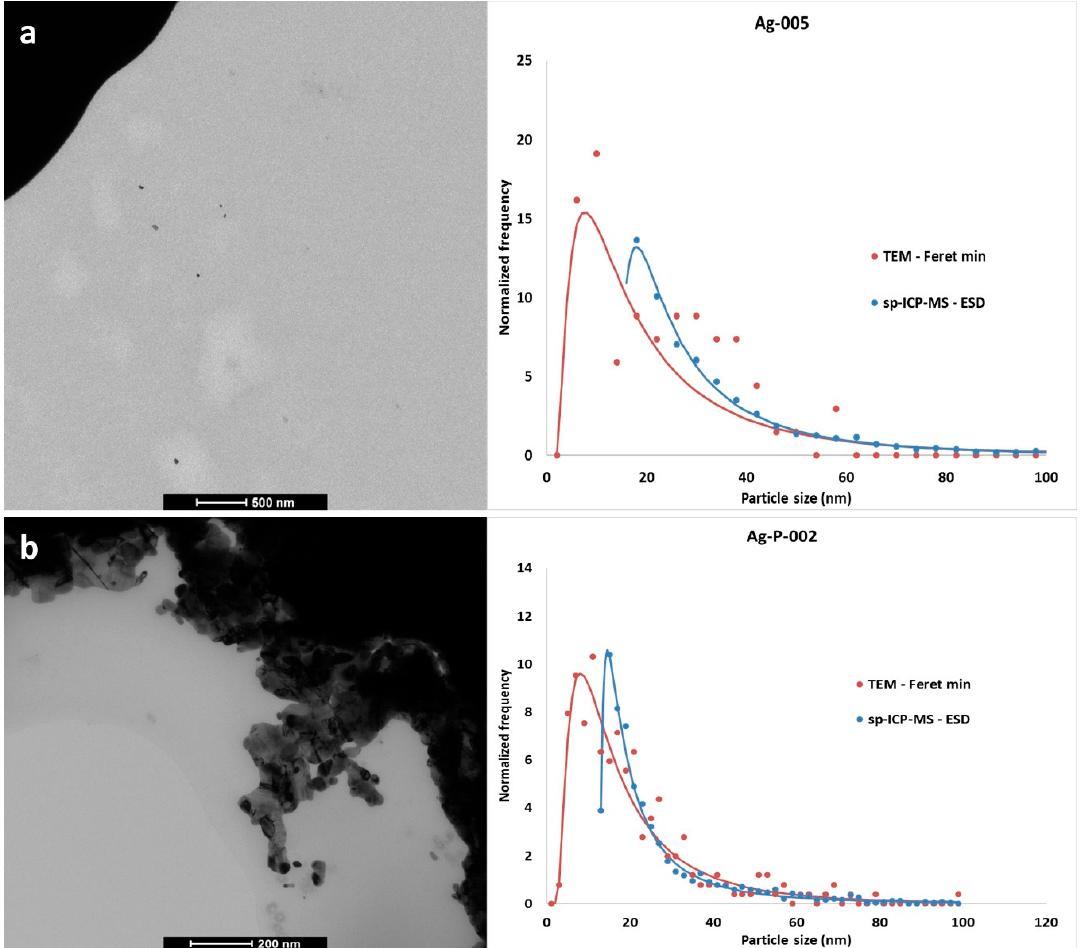
Figure A1. Representative TEM micrographs and silver particle size distributions determined by TEM and spICP ‐ MS for ( a ) a pristine E174 food additive (Ag ‐ 005); ( b ) a E174 ‐ containing food product (Ag ‐ P ‐ 002).